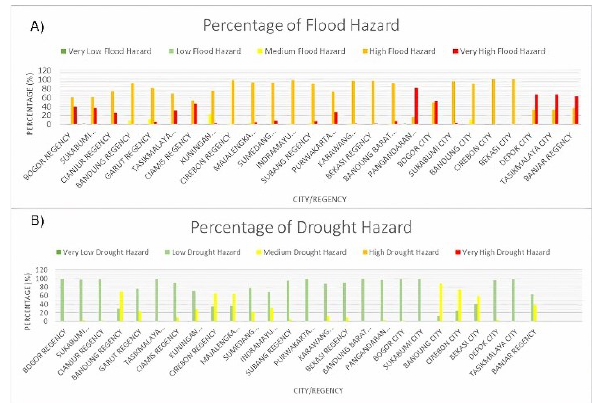
Figure 9 . Percentage of floods (A) and drought (B) of each city/regency